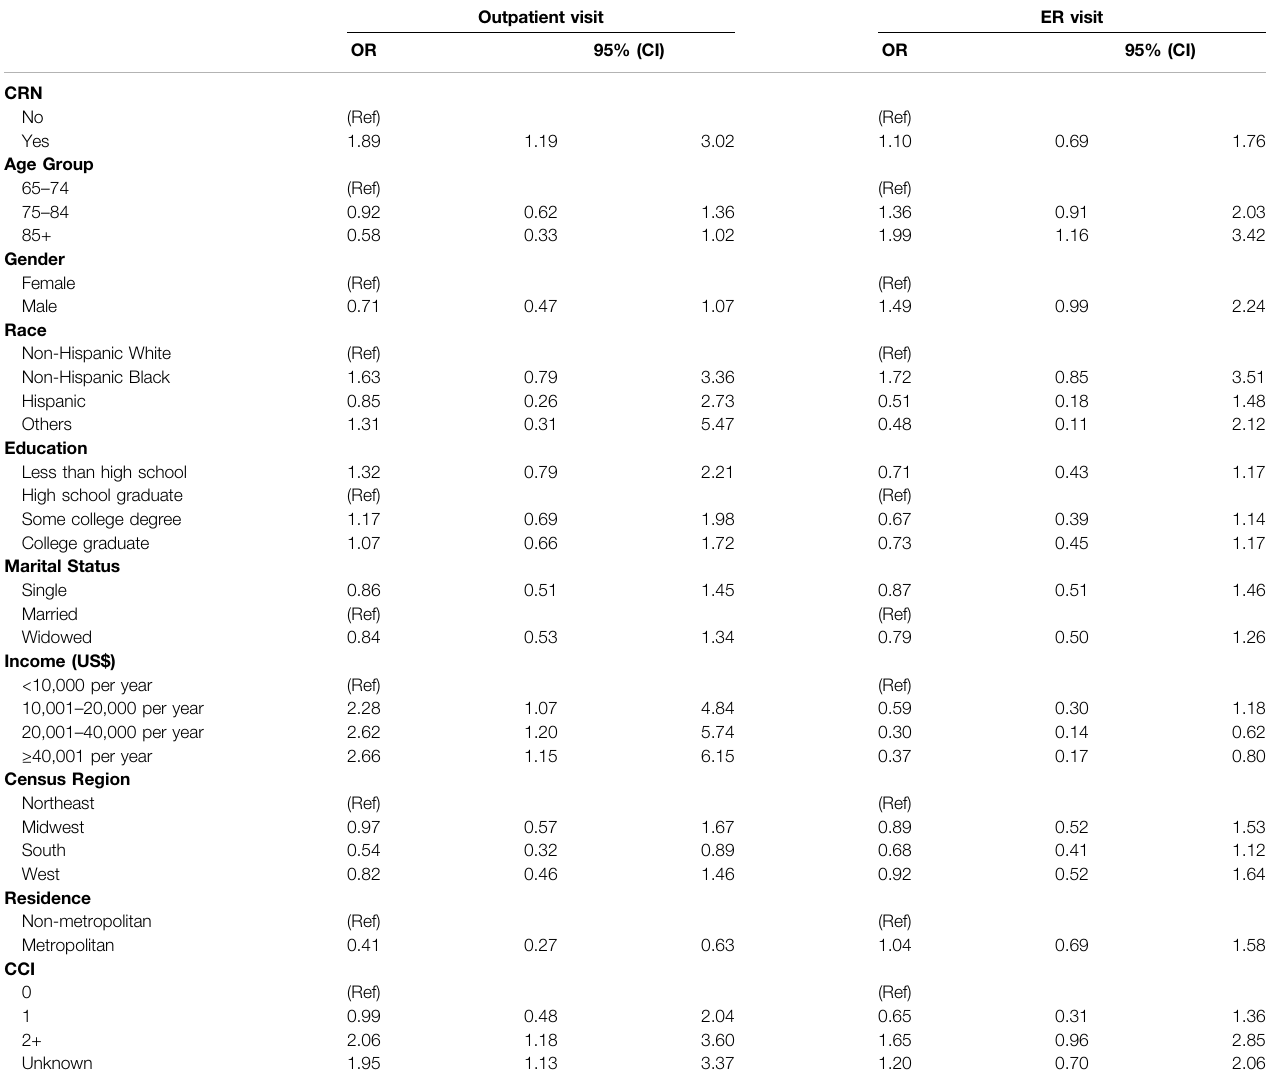
TABLE 3 | The association of CRN on patients ’ healthcare Utilization.